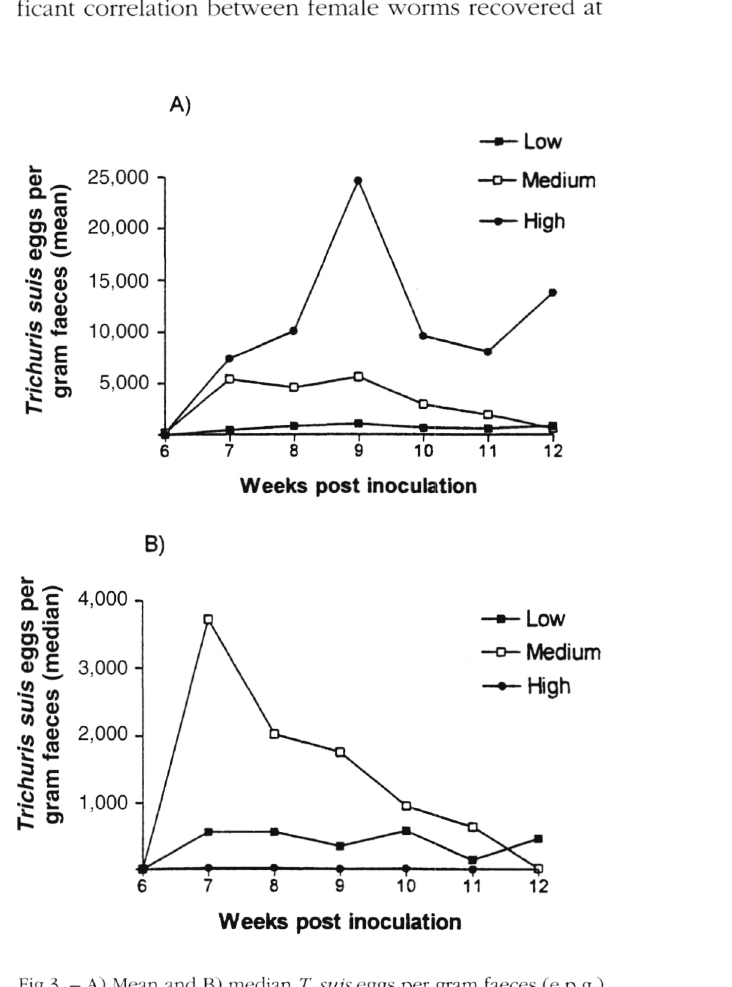
Fig.3. — A) Mean and B) median T. suis eggs per gram faeces (e.p.g.) in the low, medium and high dose groups from six to 12 weeks post